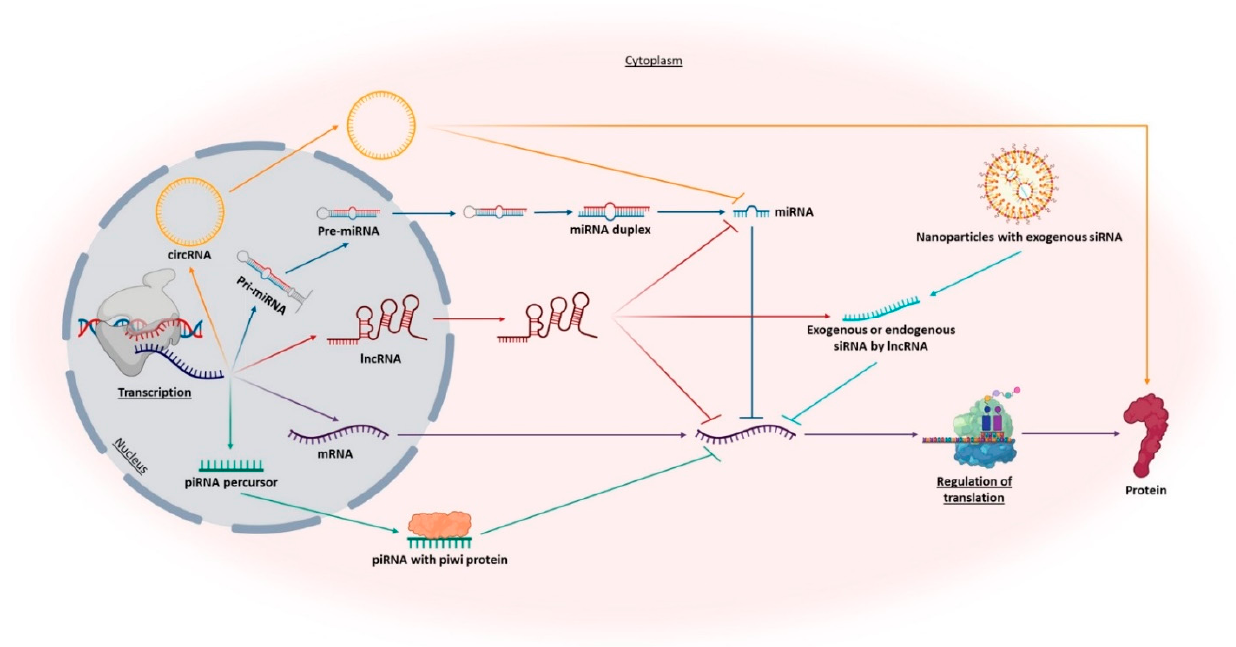
Figure 6. Representation of the roles of different promising RNAs in AD diagnosis and therapy. Including messenger RNA (mRNA), long ncRNAs (lncRNAs), circular RNAs (circRNAs), microRNAs (miRNAs), piwi-associated RNAs (piRNAs), and endogenous and exogenous small interfering RNAs (siRNAs).